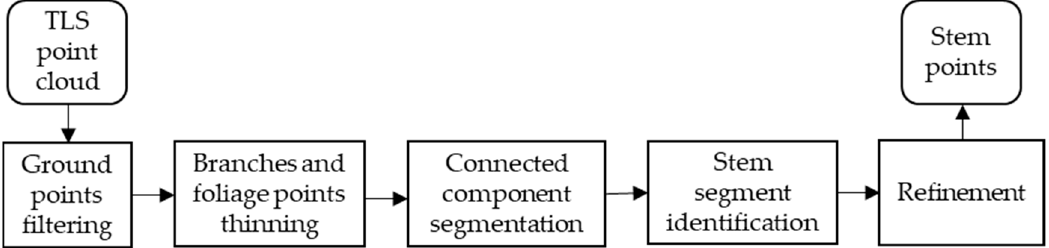
Figure 2. Overview of the proposed segment-based method for detecting tree stem points.